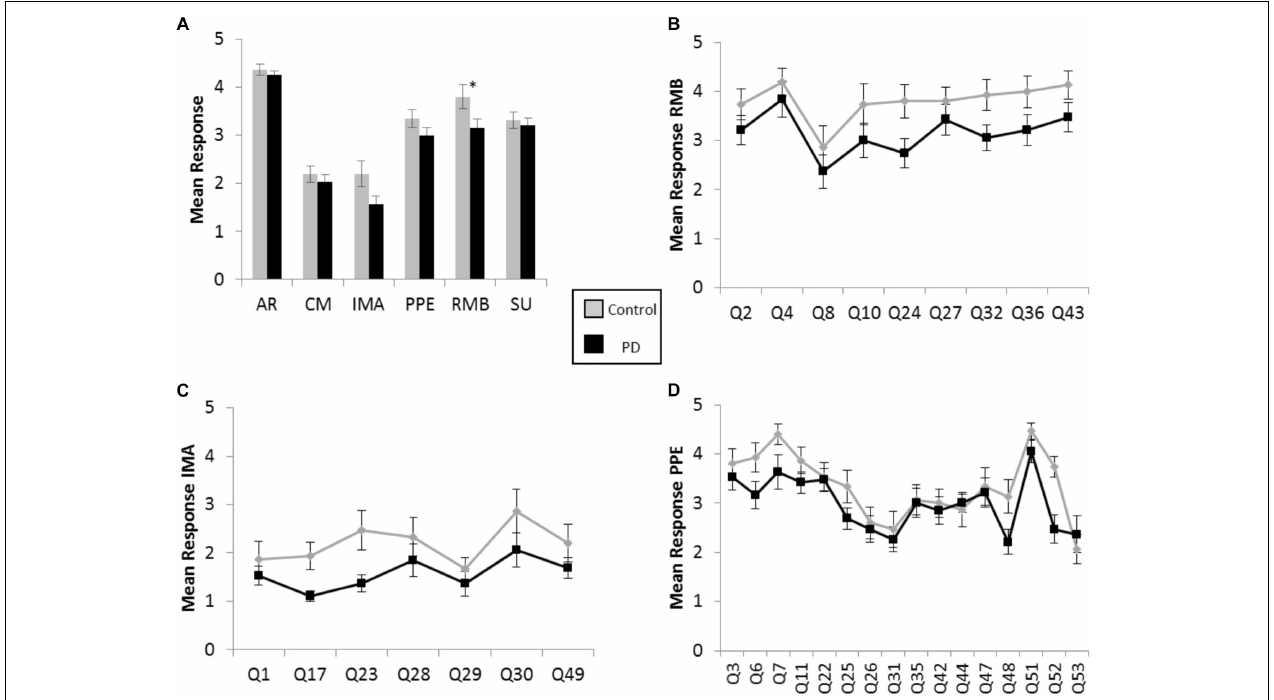
FIGURE 1 | Brief Music Experience Questionnaire (BMEQ) ratings by participants with and without PD. (A) Overall group means of six music experience scales of the BMEQ showing the categories: Affective Reactions (AR), Commitment to Music (CM), Innovative Musical Aptitude (IMA), Positive Psychotropic Effects (PPE), Reactive Musical Behavior (RMB), and Social Uplift (SU) as rated on a 5-point scale ( y axis) by participants with (Black) and without (Gray) PD. Error bars indicate the standard error of the means. Asterisks ( ∗ ) indicate significance between groups at p < 0.05 as determined by Mann–Whitney U test. Individual question means for (B) RMB, (C) IMA, and (D) PPE for participants with and without PD. Q numbers ( x axis) refer to the questions/items on the BMEQ that constitute the corresponding category. Data points represent mean responses for each participant group to that question.